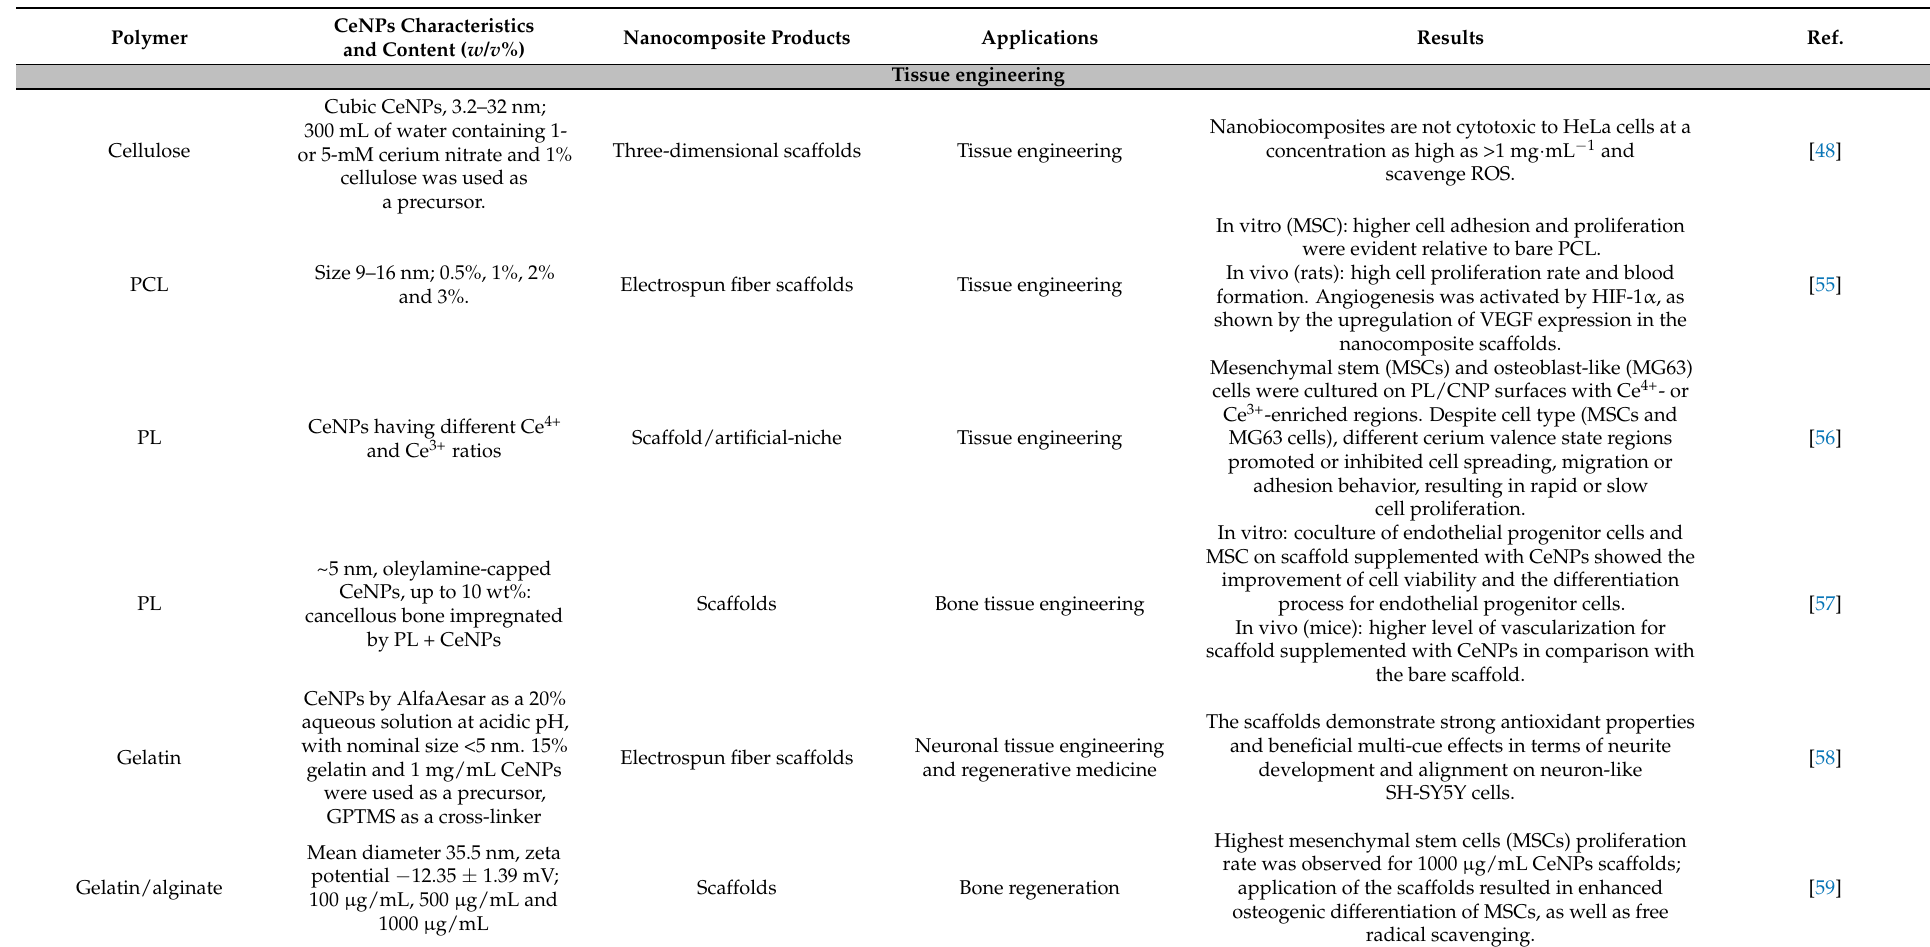
Table 1. Composition and biochemical applications of ceria-polymeric